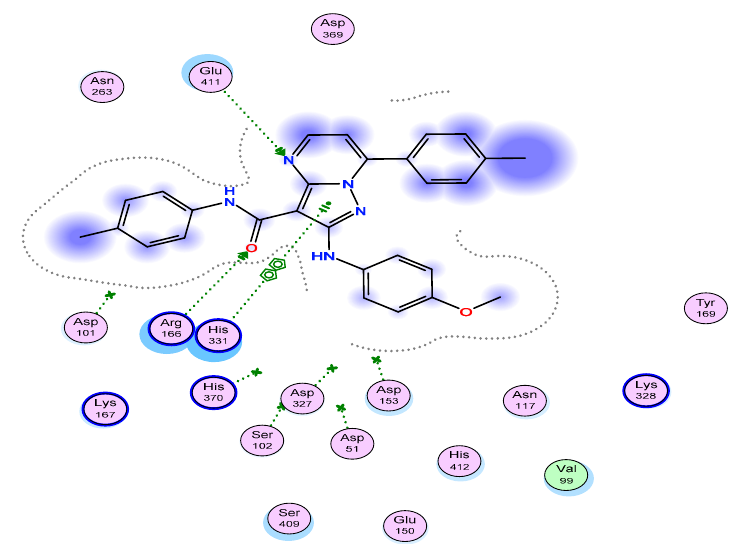
Figure 6. 2D interaction diagrams of compound 13e with alkaline phosphatase (ALP).